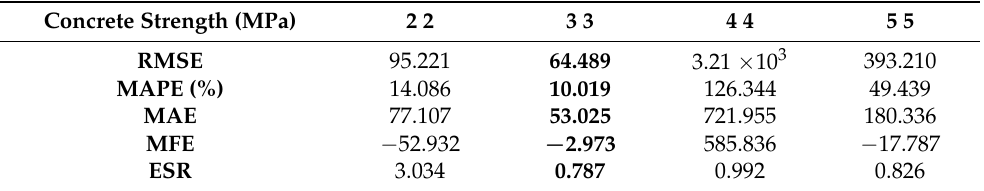
Table 9. Prediction results of the ANFIS model with the triangular membership function ‘trimf’.